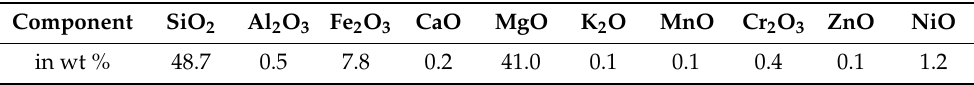
Table 1. Chemical composition of the investigated olivine from Norway (fraction between 20 and 63 µ m) as analyzed by X-ray fluorescence (XRF) in wt